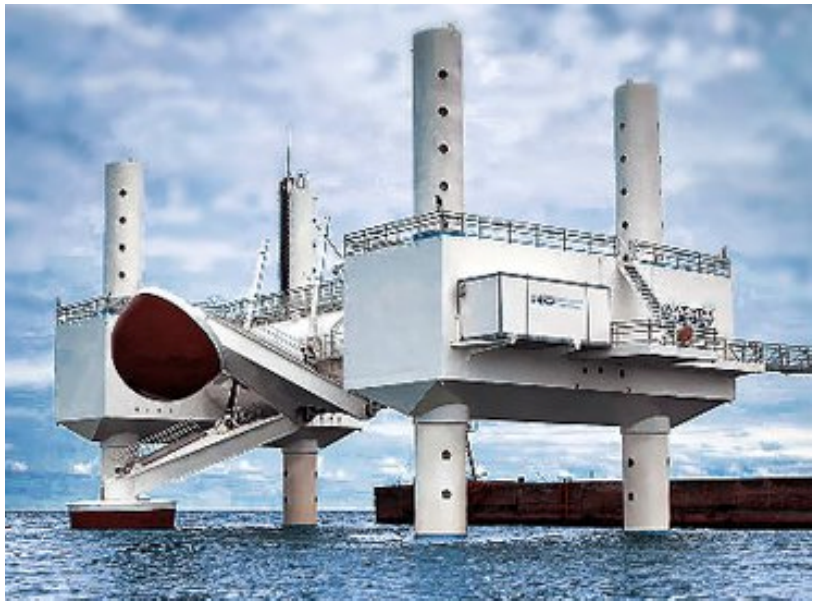
Figure 2. Picture of the Wavestar prototype located at Hanstholm (Denmark) with one floater in production mode and one lifted out of the water (storm protection